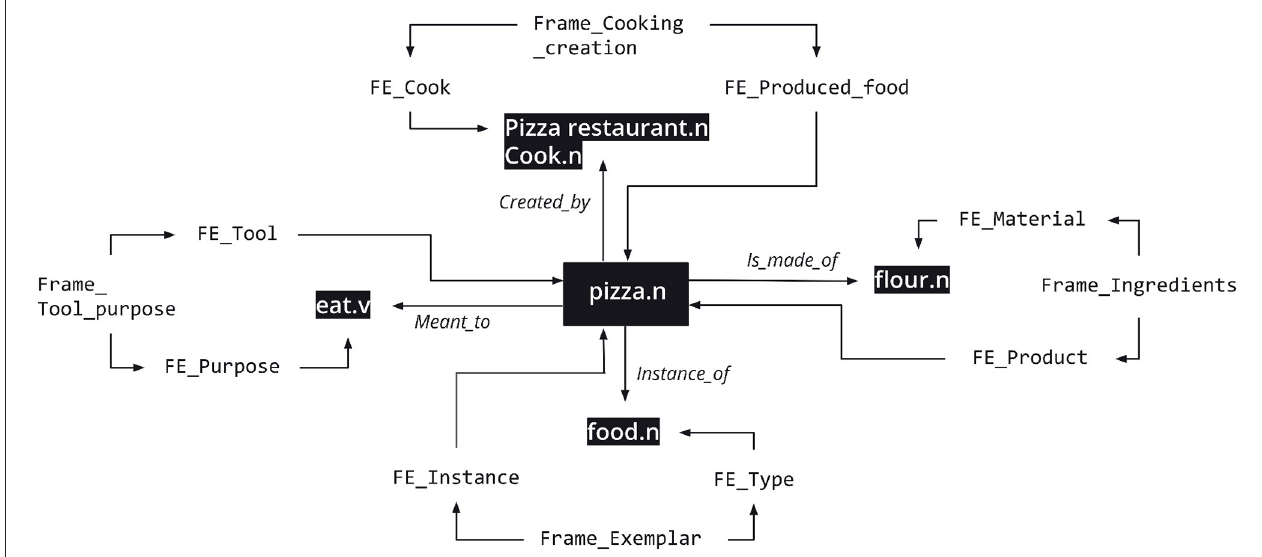
FIGURE 5 | Ternary Qualia Relations for pizza.n . Reproduced with permission from Belcavello et al. (2020).